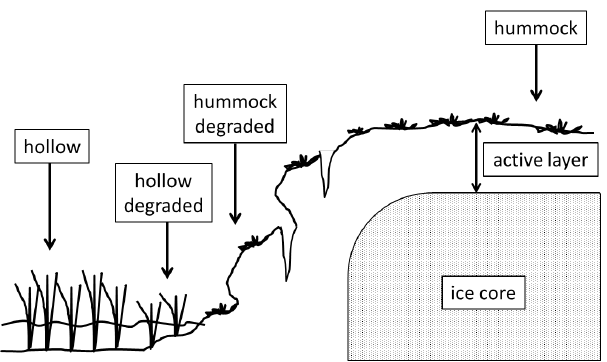
Figure 2. Transect of the sampling at the palsa peatlands with an approximately distance of 4.0–8.0m between the outer sampling